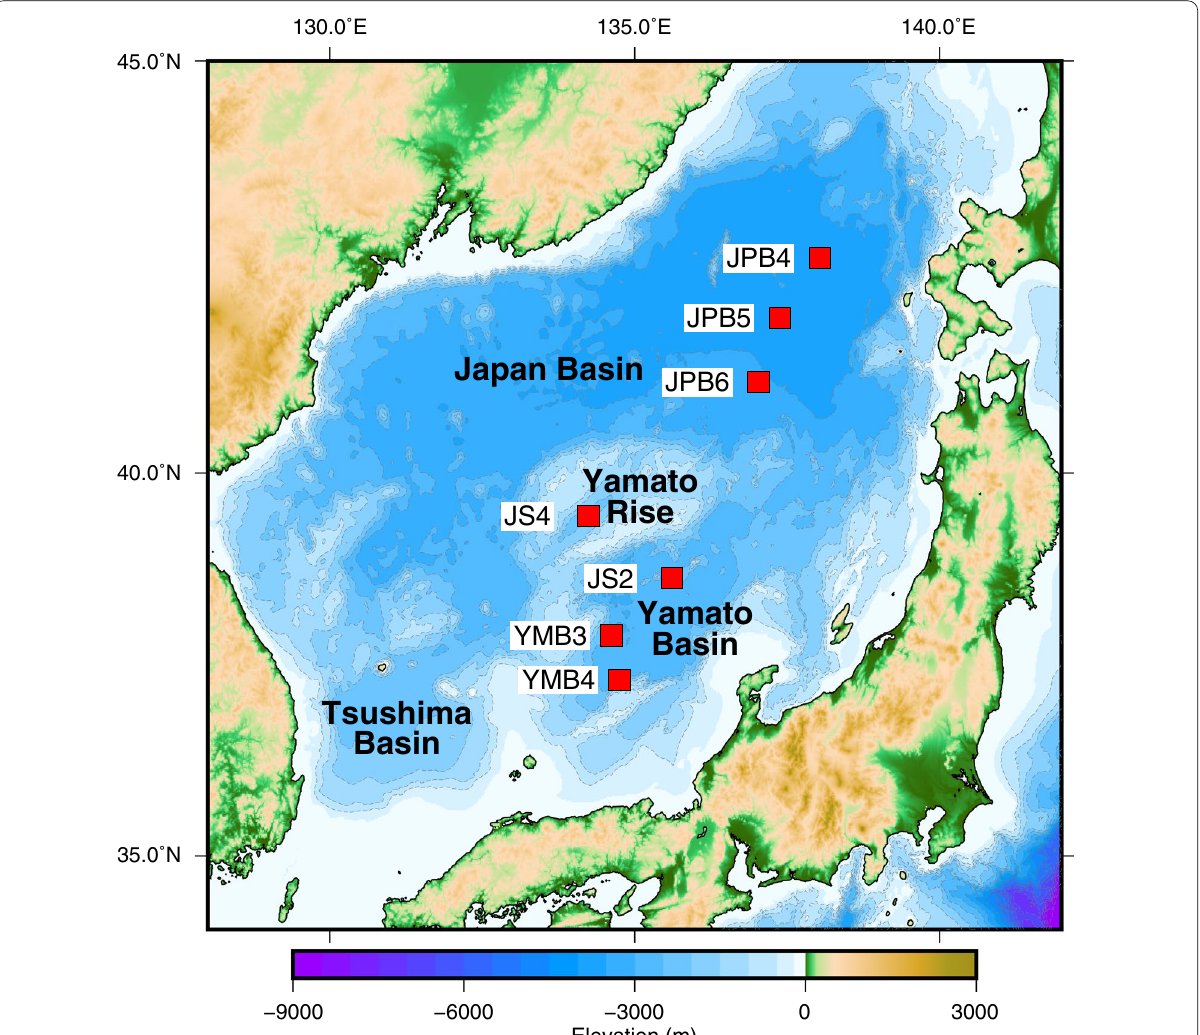
Fig. 1 Tectonic setting of the study area and station arrangement. Red squares denote observation sites where broadband seismometers were